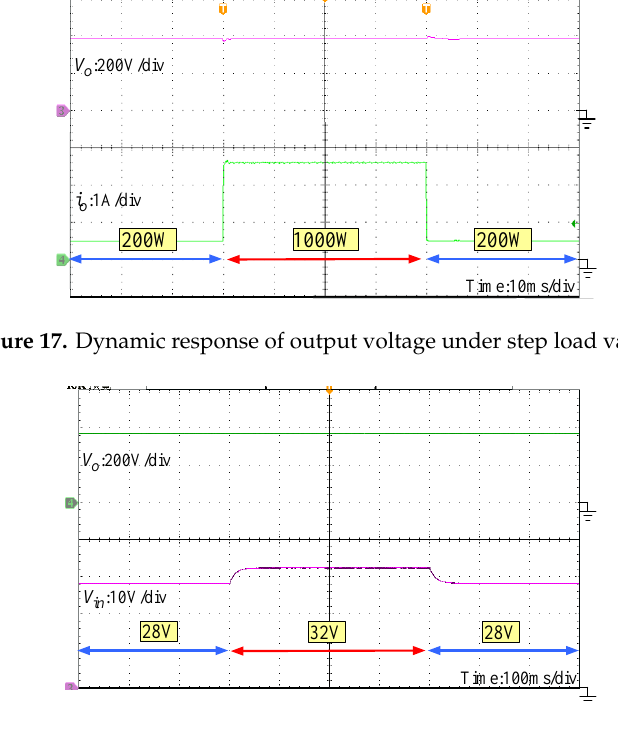
Figure 18. Dynamic response of output voltage under input voltage variation.